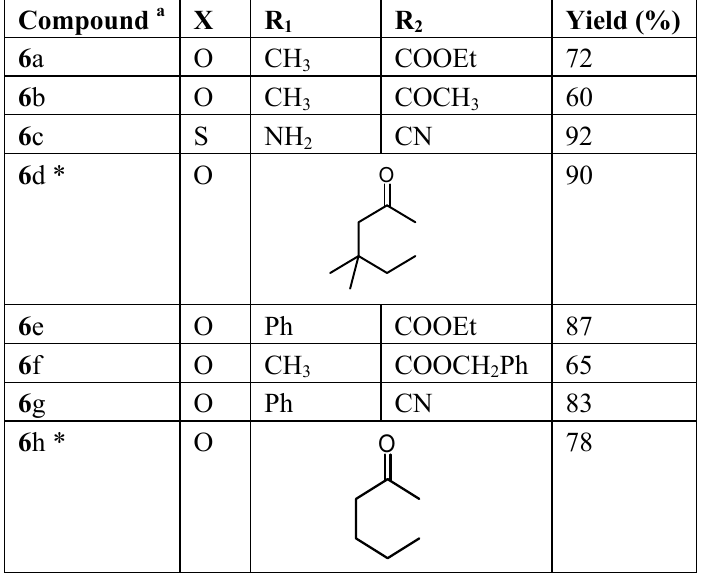
Table 2. Compounds 6a–h and their yields.